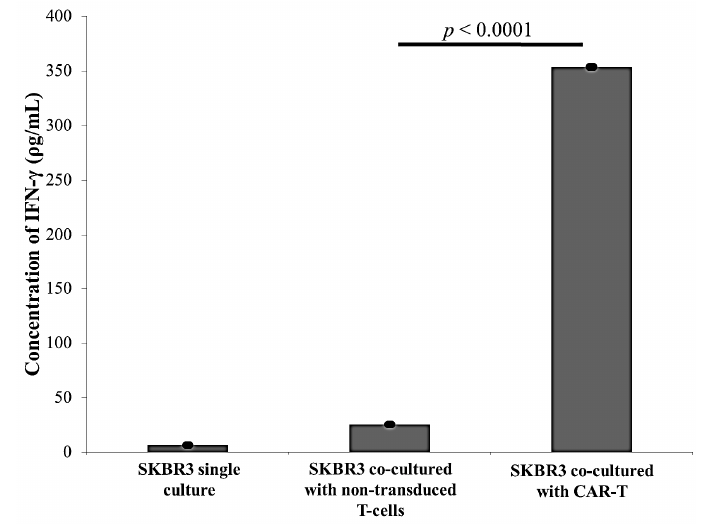
Figure 4. Detection of interferon- γ production upon co-culture of CAR-T cells with SKBR3 cells. The figure shows interferon-gamma (IFN- γ ) secretion in the supernatant of the T-cells and ERBB2 overexpressing cancer cell line, SKBR3, after 72 h of co-culture. Only 6.42 pg/mL IFN- γ was produced in the SKBR3 single culture supernatants ( n = 6). SKBR3 co-cultured with non-transduced T-cells showed 25.57 pg/mL IFN- γ production ( n = 6). SKBR3 co-cultured with CAR-T showed IFN- γ at concentrations of 353.63 ± 10.64 pg/mL was produced in the supernatant of this experimental group with a significant p value of p < 0.0001 ( n = 6) compared to that of SKBR3 co-cultured with non-transduced T-cells. The X-axis indicates the experimental groups, while the Y-axis indicates the concentration of the IFN- γ (pg/mL) produced with the scale bar up to 400 pg/mL. The resulting data was reported as a bar chart of the experimental mean ± standard error of the mean (S.E.M.) ( n = 6). The p < 0.0001 was determined with respect to SKBR3 co-cultured with CAR-T compared to non-transduced T-cells by ordinary one-way analysis of variance (ANOVA).